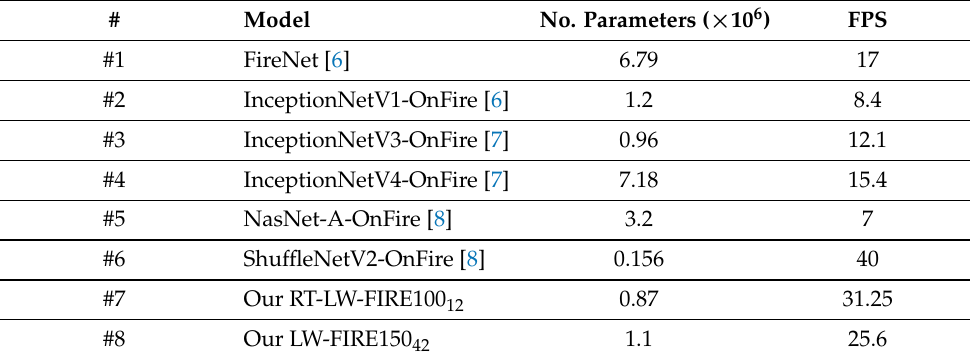
Table 9. Total number of parameters used in each